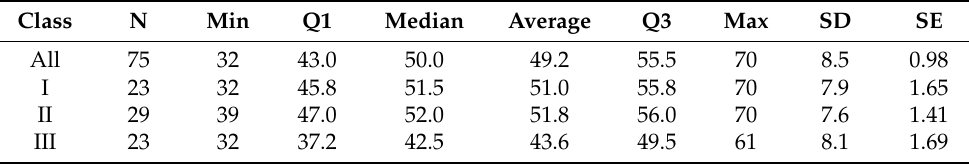
Table 1. Sagittal condylar inclination (SCI) of the left temporomandibular joint (TMJ).